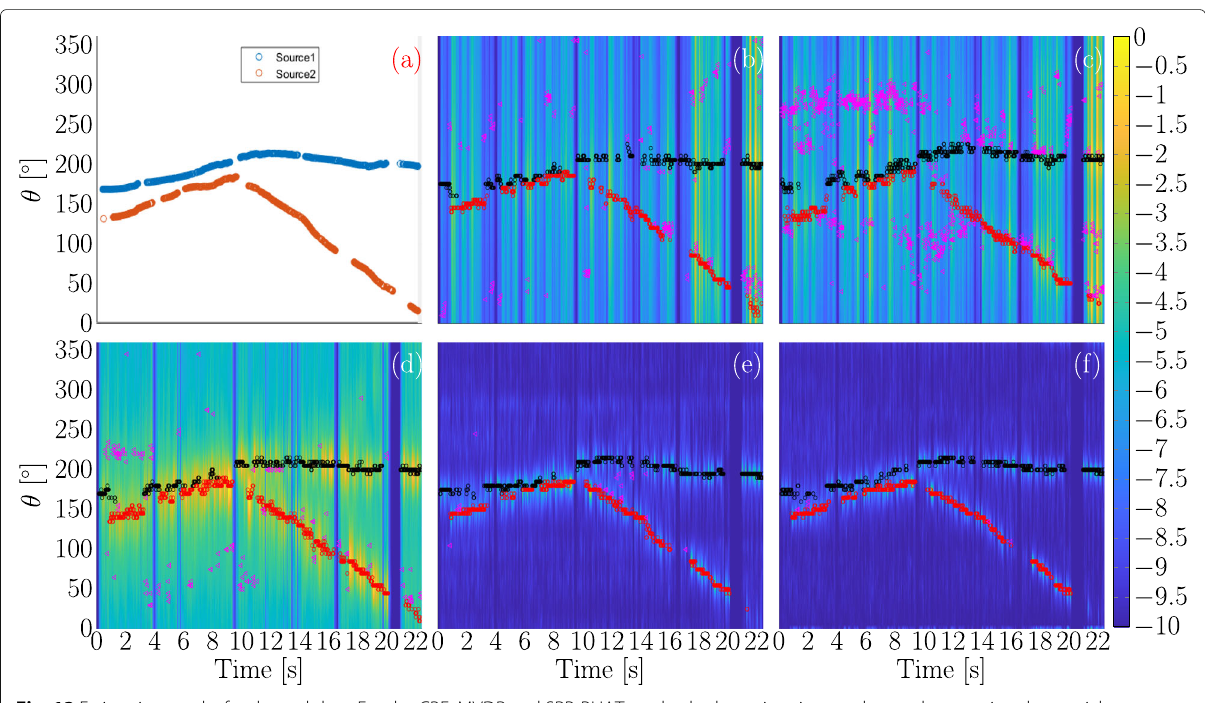
Fig. 13 Estimation results for the real data. For the CBF, MVDR and SRP-PHAT methods, the estimation results are shown using the spatial spectrum of all frames. For the MSBL-EM and proposed SAVE-MSBL-EM method, the estimation results are shown using the weights w of all frames. All the data are normalized frame by frame. a The truth trajectory of two source. b The results of CBF based method. c The results of MVDR based method. d The results of SRP-PHAT method. e The results of MSBL-based method. f The results of the proposed method